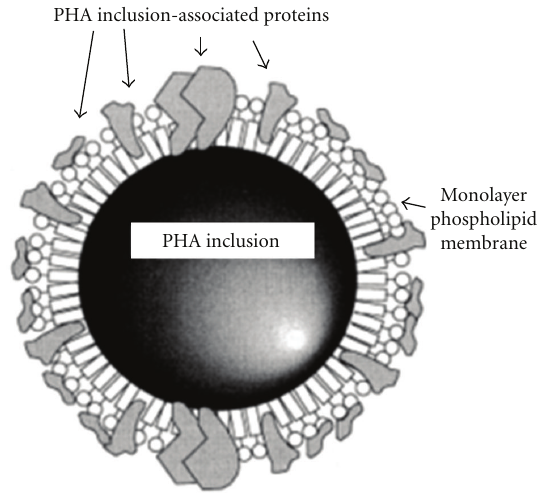
Figure 2: The structure of in vivo PHA inclusions and its associa- tion with specific proteins